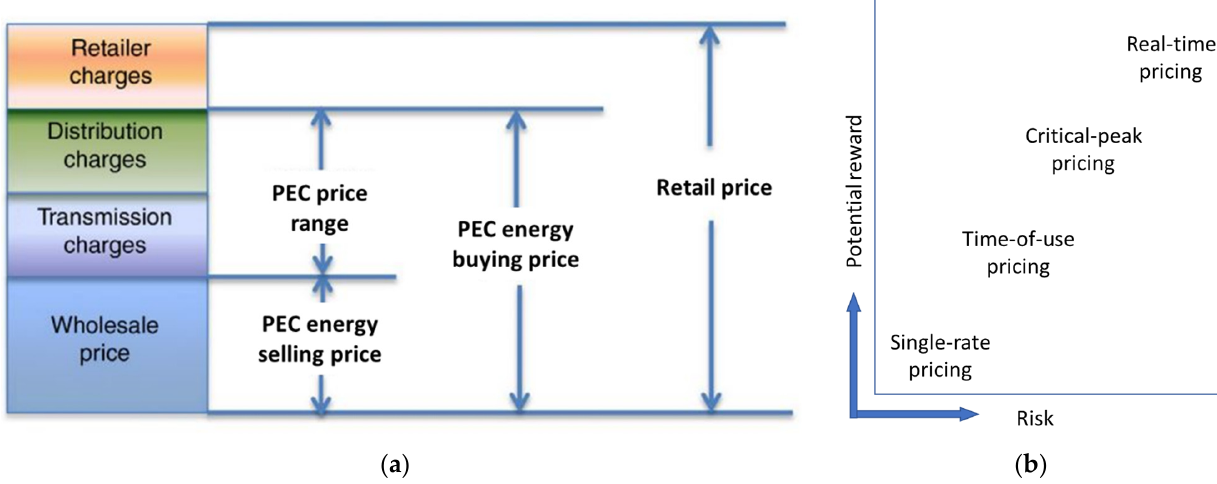
Figure 10. ( a ) PEC selling/buying price, ( b ) Risk and reward of various pricing scheme in PEC. Partially reprinted with the permission from [23].